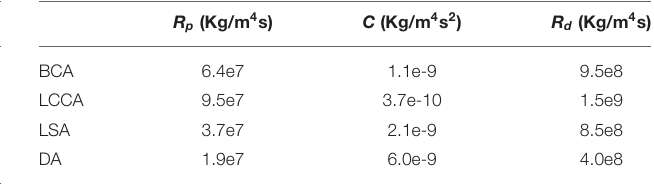
TABLE 1 | Table reporting the parameters for the Windkessel models for the SOL FSI simulation.